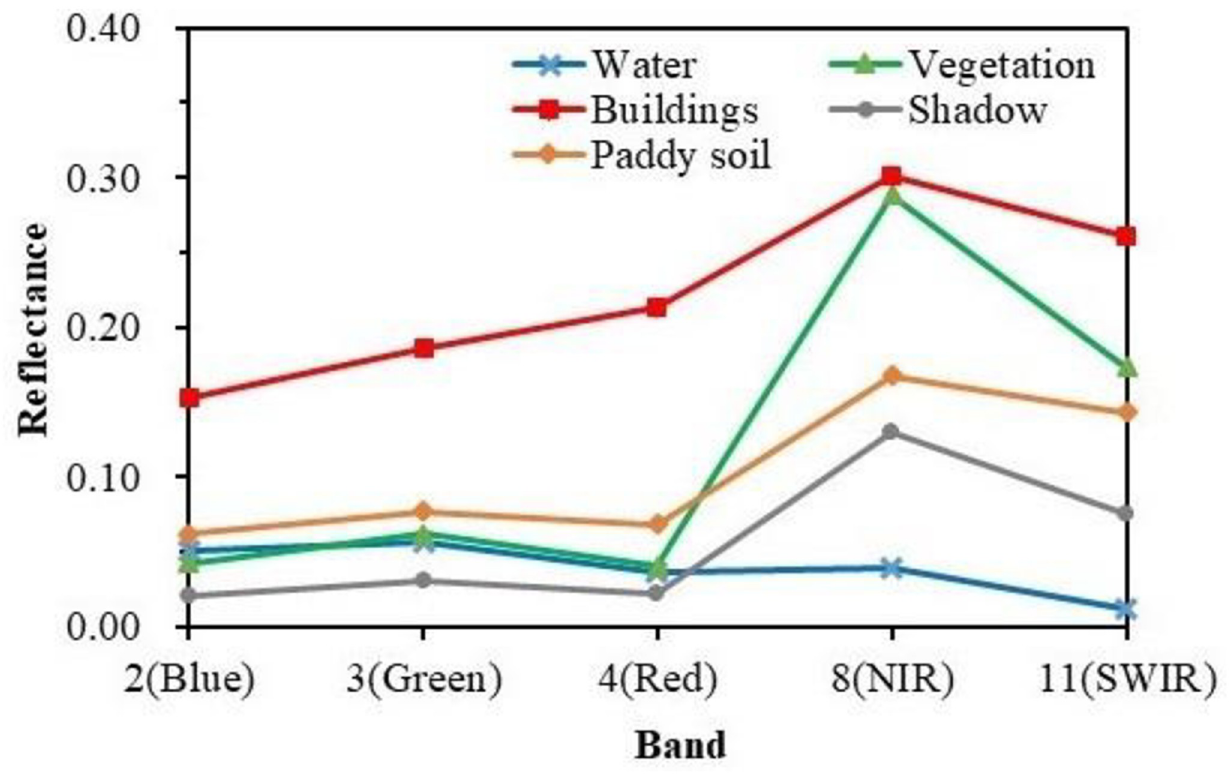
Fig 6. Spectral characteristic curve of typical